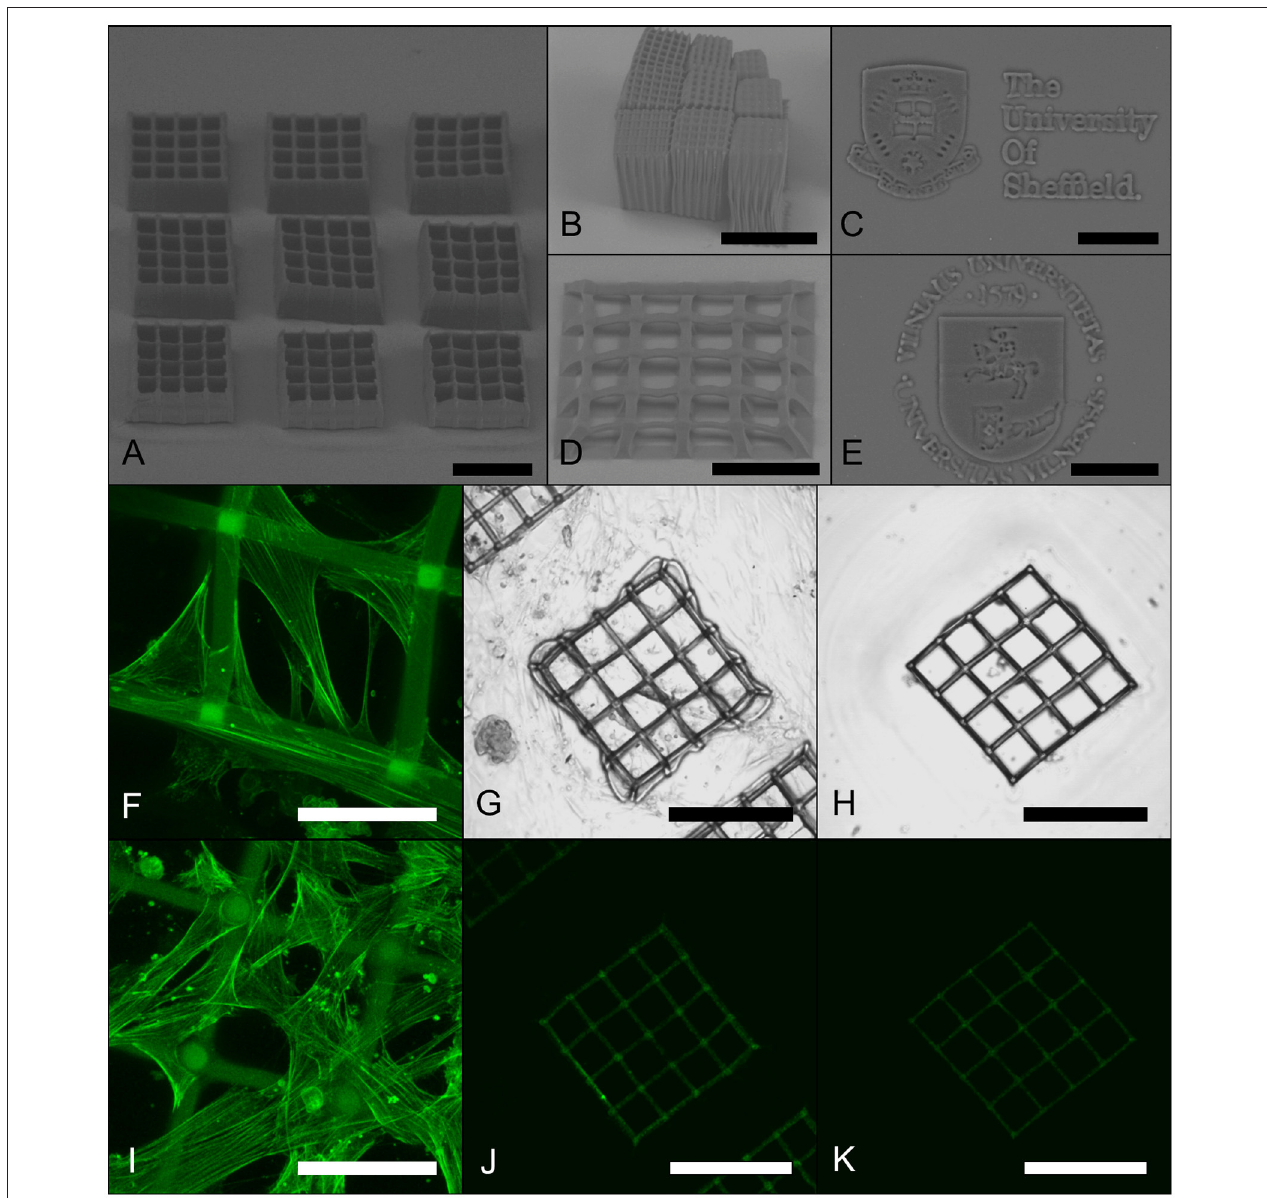
FIGURE 13 | Representative images of 3D PGS-M structures produced by 2PP. Structures produced using 20x 0.8 NA (A,D) , 10x 0.3 NA (B) , and 63x 1.4 NA (C,E) objective lenses examined using SEM. Vascular SMCs were cultured on scaffolds and then stained for F actin filaments using Phalloidin-FITC. Projections of 3D confocal images of scaffolds after 1 day (F) and 7 days (I) of SMC culture. Unstained control cultures after 7 days are shown as transmitted light DIC (G) and fluorescence (J) images, along with unseeded, but stained, controls (H,K) . Scale bars are 200 µ m (A,B,D,G,H,J,K) and 50 µ m (C,E,F,I)